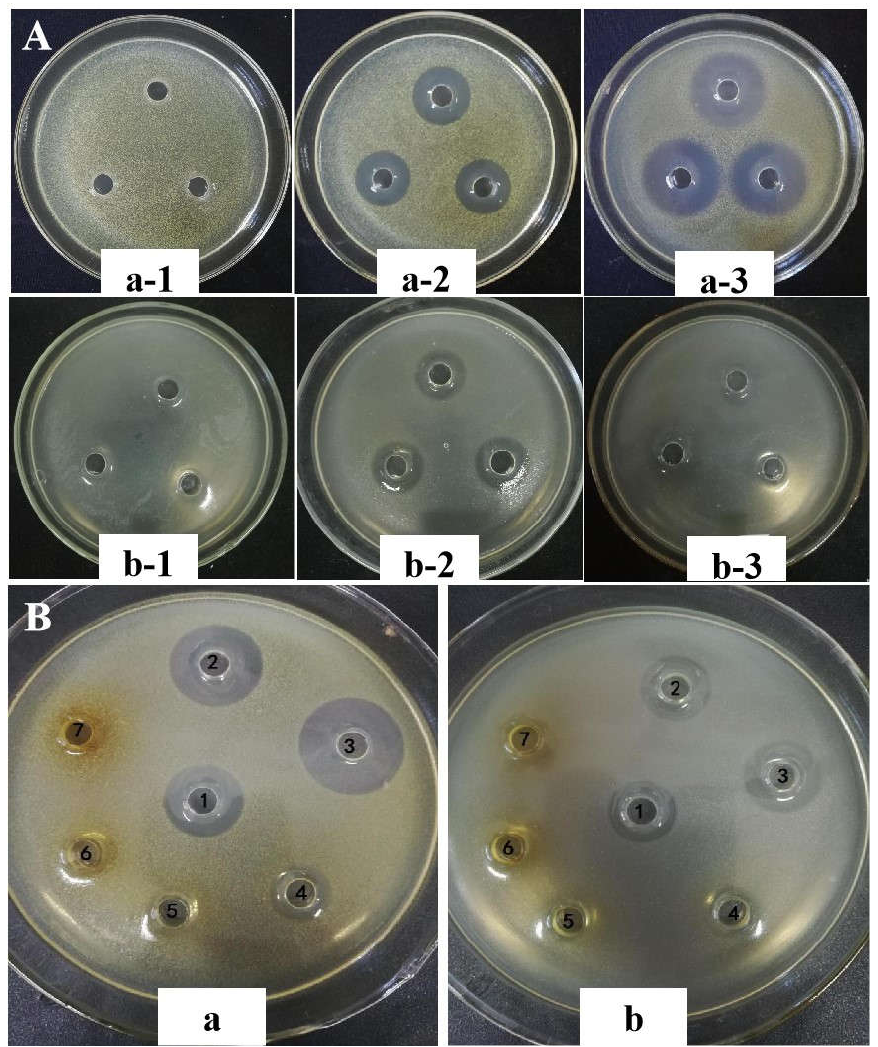
Figure 1. Inhibition zones of the ethyl acetate fraction ( A ) and its sub-fractions ( B ) from pickled and dried mustard against S. aureus (a) and P. fluorescens (b). (a-1) S. aureus control (treated with ethanol); (a-2) S. aureus treated with 20 mg/mL ethyl acetate fraction; (a-3) S. aureus treated with 70 μg/mL tetracycline; (b-1) P. fluorescens control (treated with ethanol); (b-2) P. fluorescens treated with 20 mg/mL ethyl acetate fraction; (b-3) P. fluorescens treated with 70 μg/mL tetracycline. No. 1 to No. 7 were Fr 1–Fr 7. Table 1. Diameters of inhibition zones of ethyl acetate fraction and its sub-fractions from pickled and dried mustard.